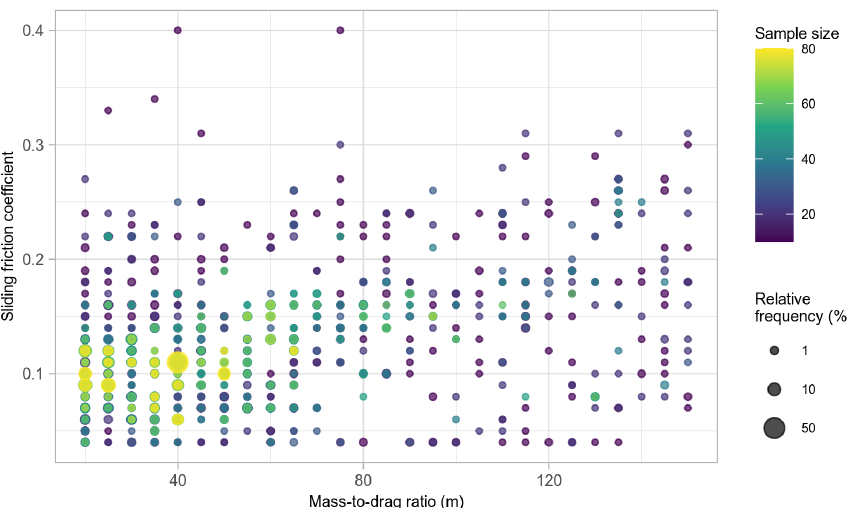
Figure 15. Relative frequencies of optimal parameter combinations for different training sample sizes computed using spatial cross-